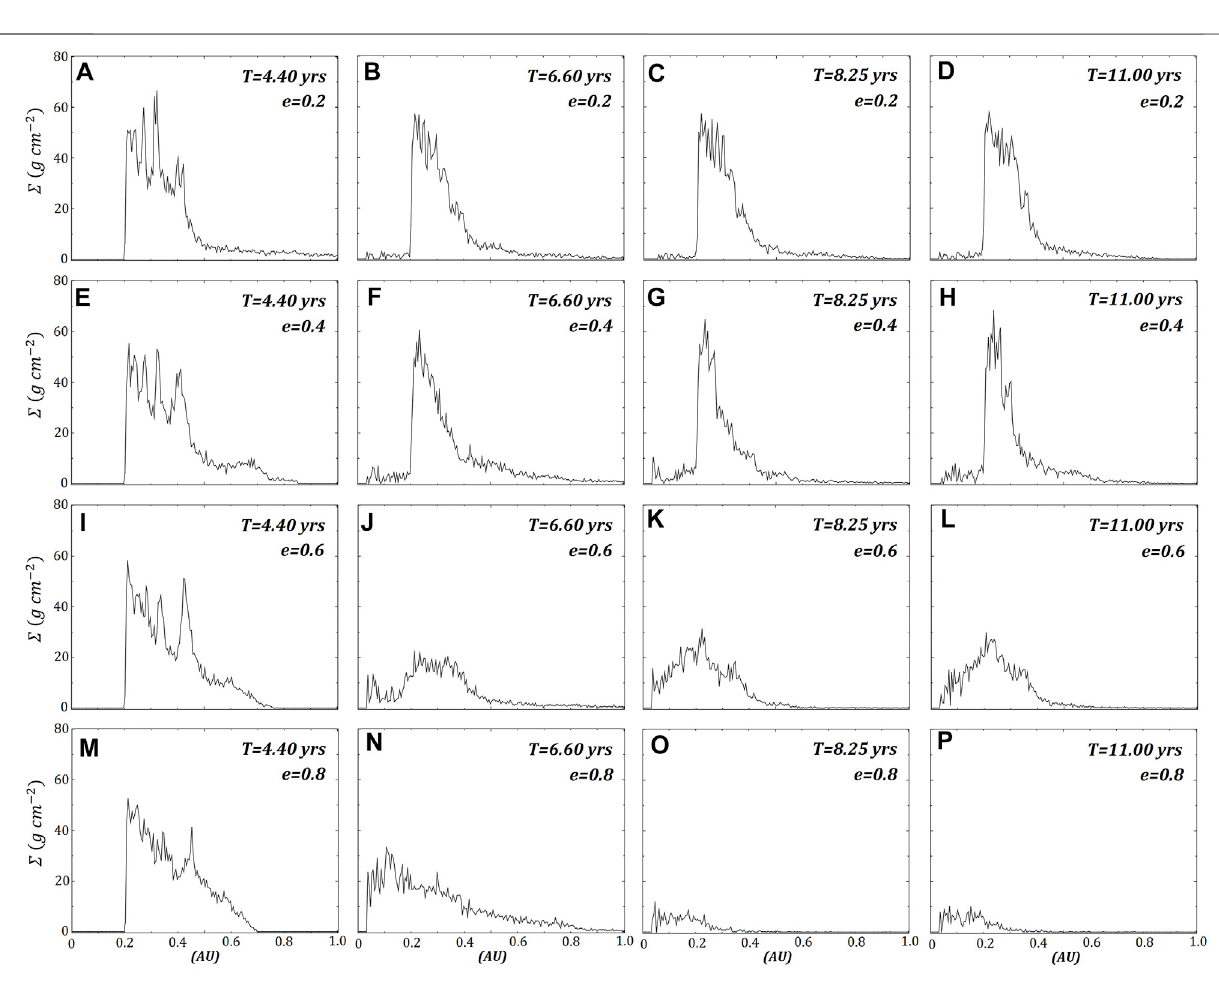
Frontiers in Astronomy and Space Sciences |